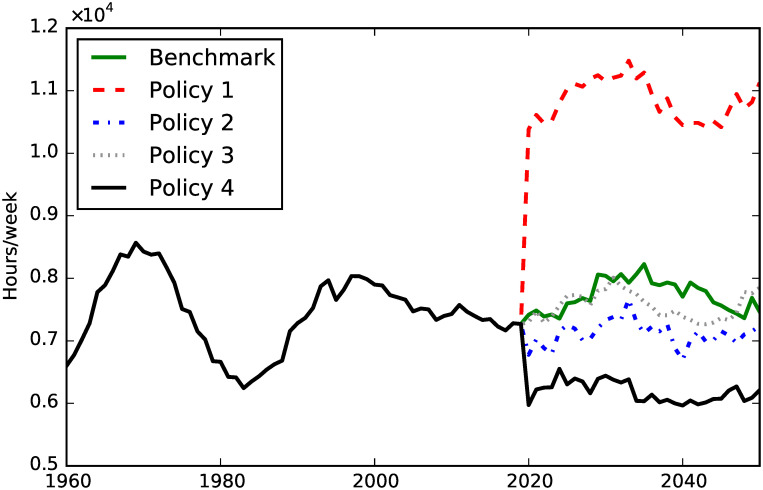
Formal child care.